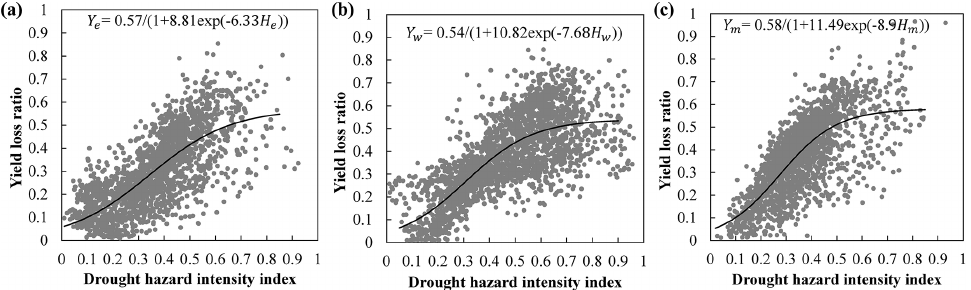
Figure 9. Physical vulnerability curve to drought hazard of spring maize in the (a) eastern part (b) middle part and (c) western part of the farming–pastoral ecotone in Northern